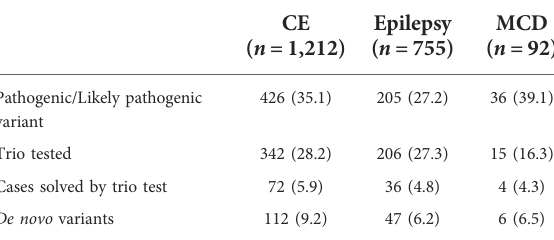
TABLE 1 Statistics of targeted gene